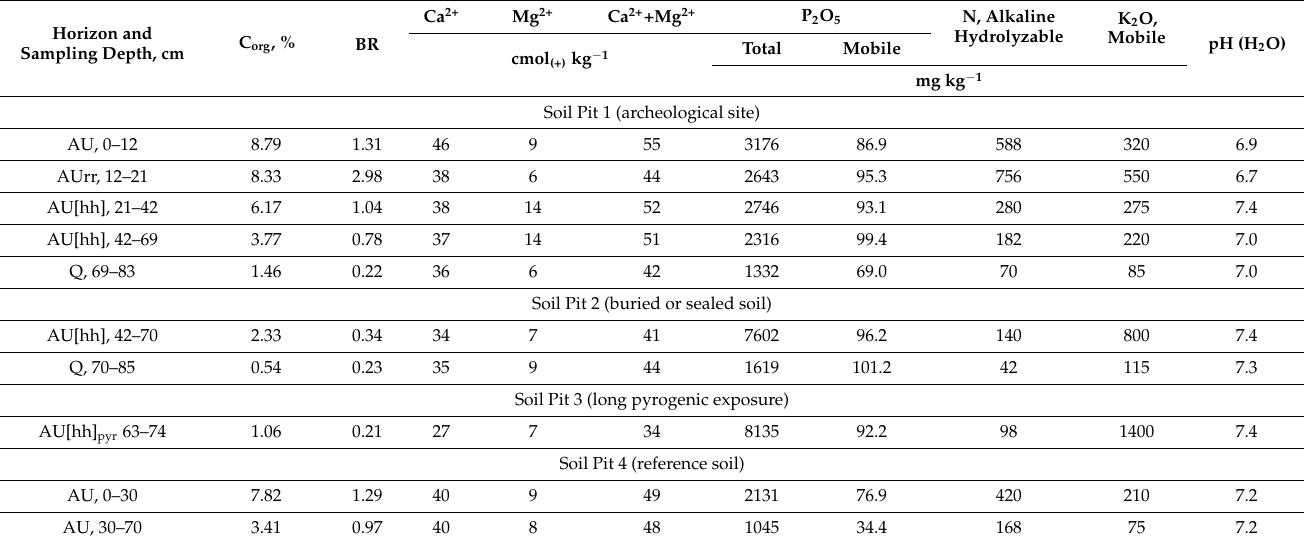
Table 1. Chemical properties and basal respiration (BR, µ g CO 2 –C g − 1 soil h − 1 ) of the archeological site’s soil. Horizon and Sampling Depth,